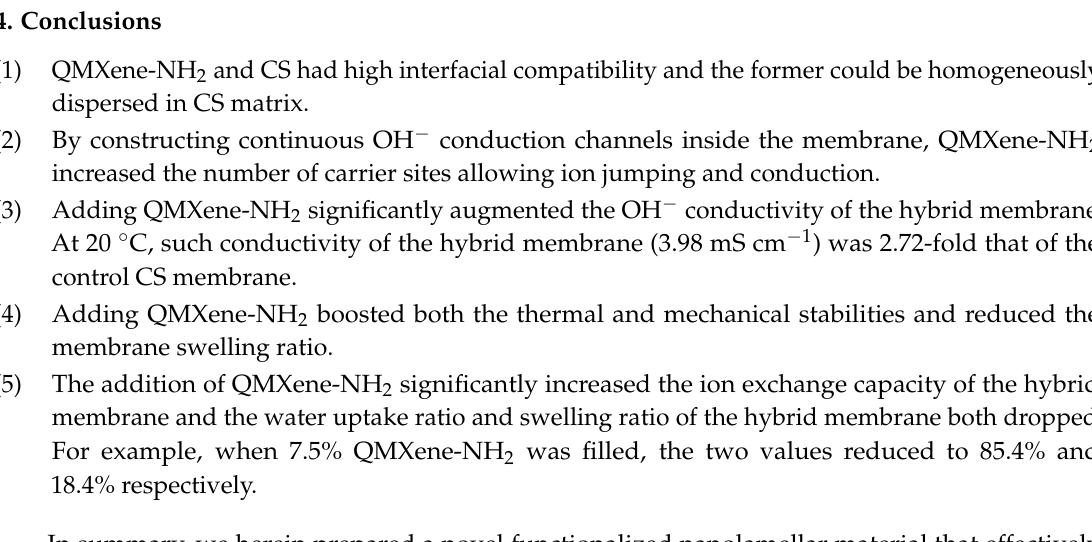
Figure 9. ( a ) Temperature-dependent OH − conductivity and ( b ) Arrhenius plots of OH − conductivity of control CS and CS/QMXene-NH 2 membranes.